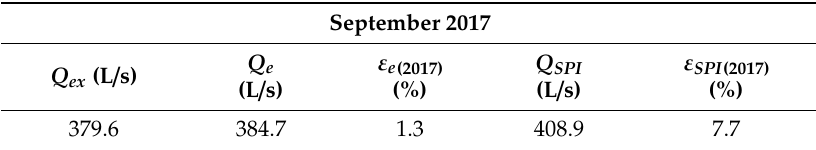
Table 2. Comparison between exploited discharge ( Q ex ), estimate discharge ( Q e ) and estimated discharge with SPI index ( Q SPI ).